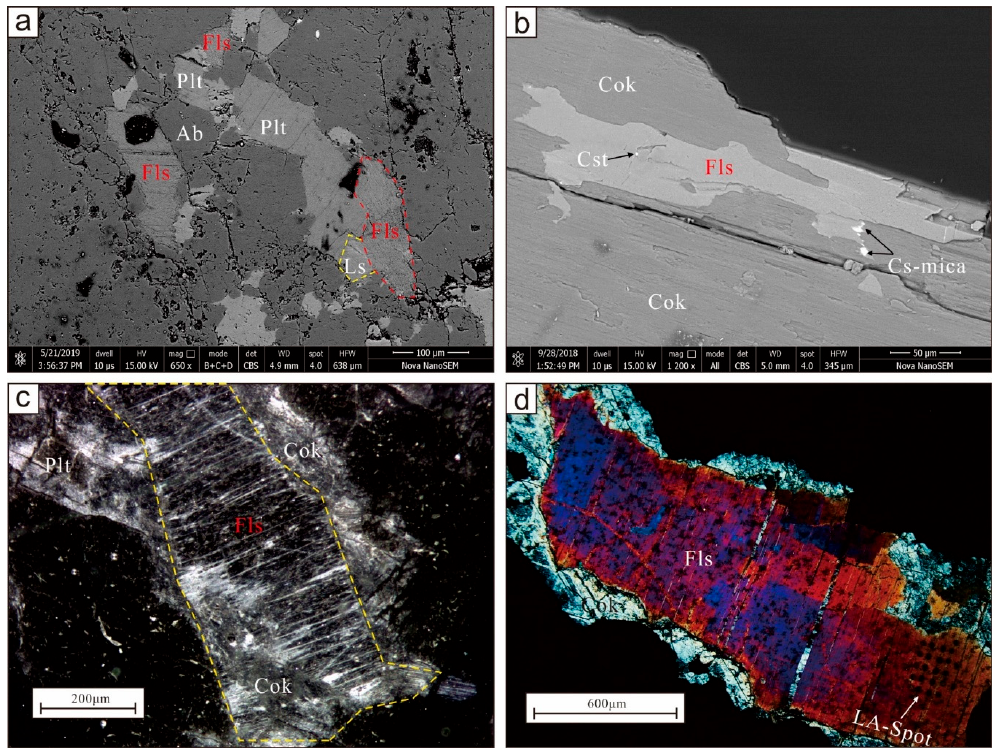
Figure 1. ( a ) and ( b ) Backscattered electron images of mineral aggregates; ( c ) fluorluanshiweiite under binocular microscope; ( d ) grains for single-crystal X-ray analysis under cross-polarized light. Fls, fluorluanshiweiite; Ls, luanshiweiite; Plt, polylithionite; Cok, cookeite; Cst, cassiterite; Ab,